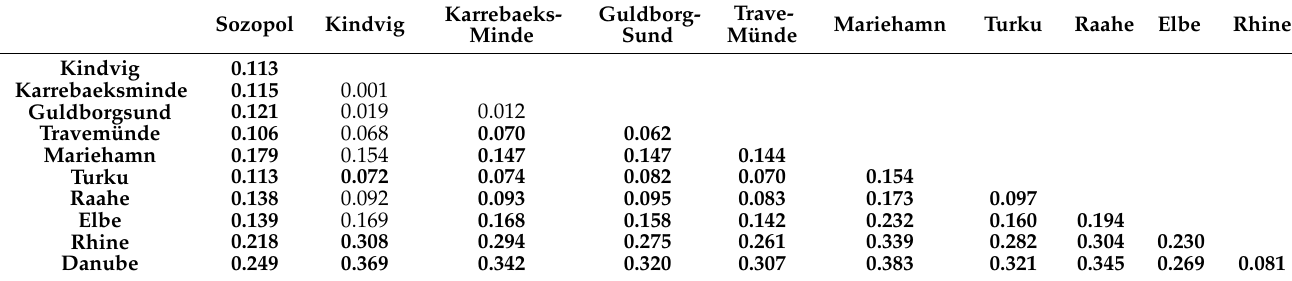
Table 3. Pairwise F ST of 11 population samples of round goby ( Neogobius melanostomus ) using 13,847 SNPs, calculated according to Weir and Cockerham (1984). Bold values indicate significance of the estimates and were tested using Fisher’s exact tests with 5000 Monte Carlo replicates and false discovery rate corrections.